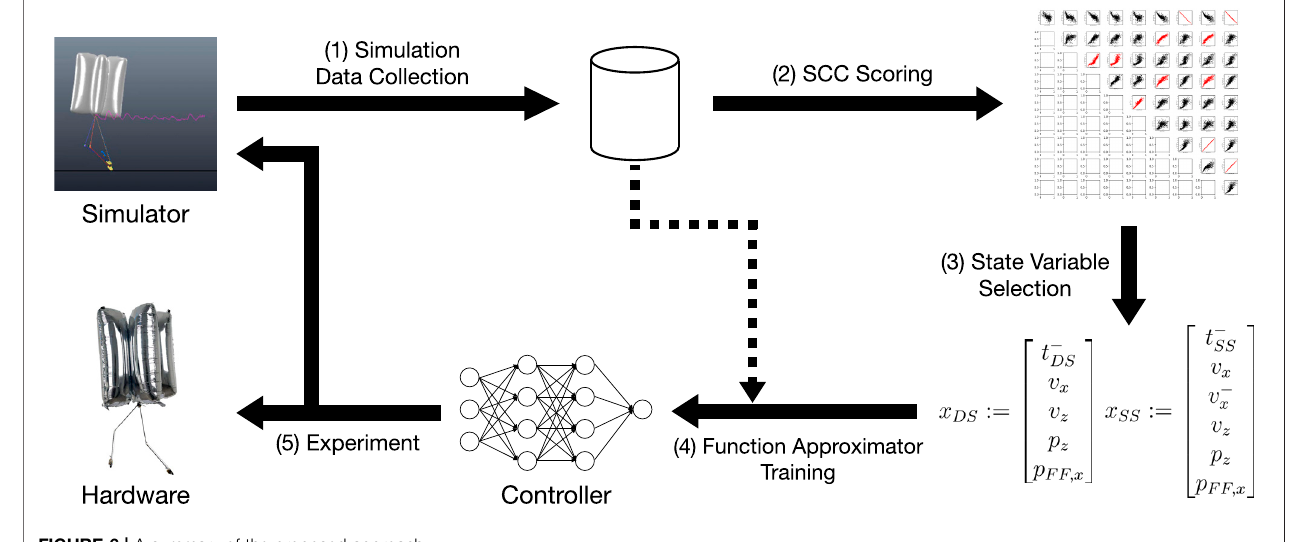
FIGURE 6 | A summary of the proposed approach.